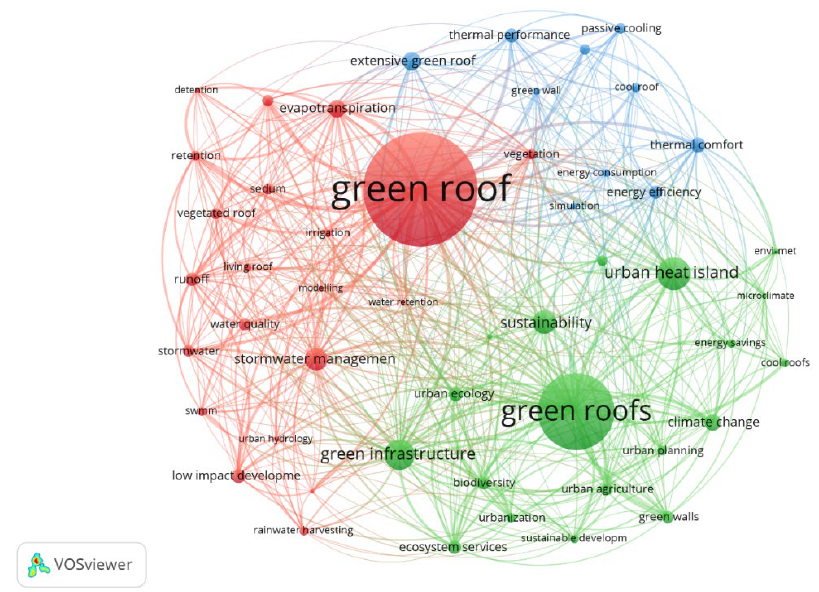
Figure 3. Keywords Review in Green Roof Research .